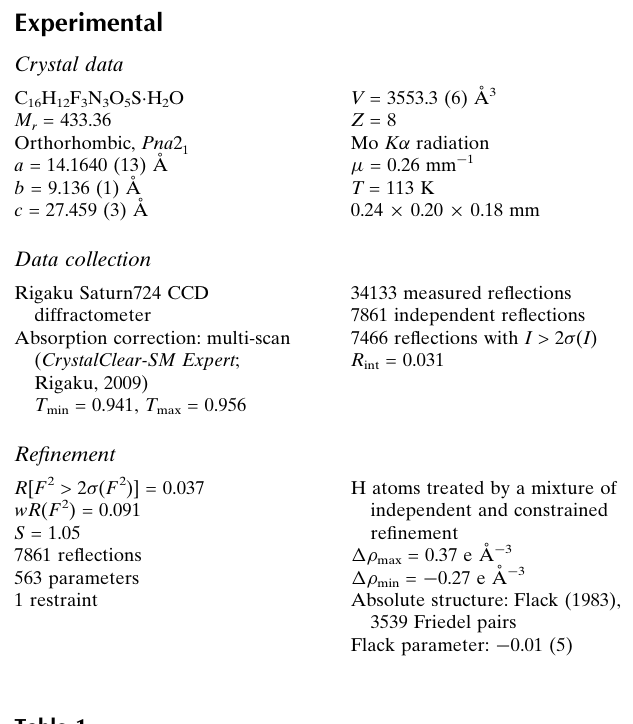
Hydrogen-bond geometry (A˚ , (cid:3) ). D —H (cid:2)(cid:2)(cid:2) A